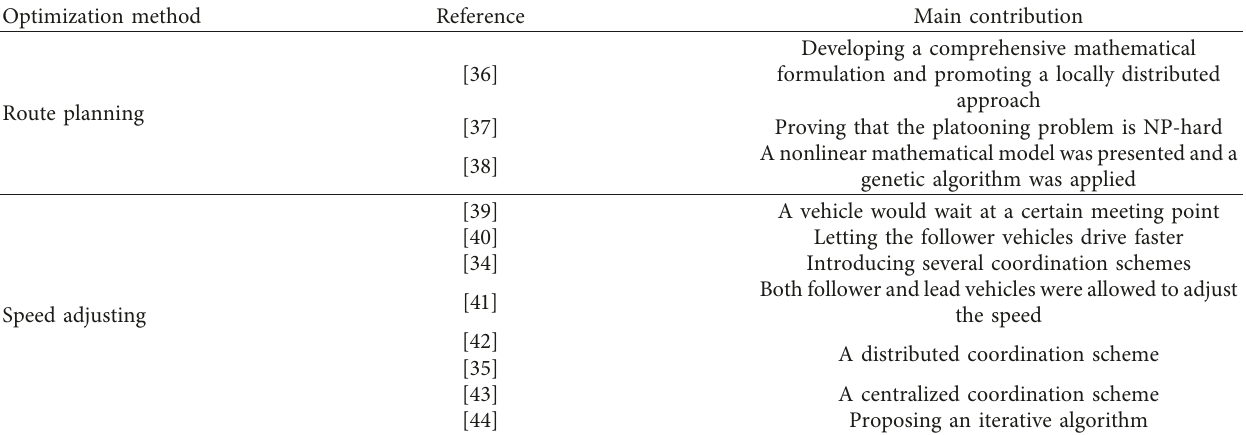
Table 2: Optimizations of truck platooning